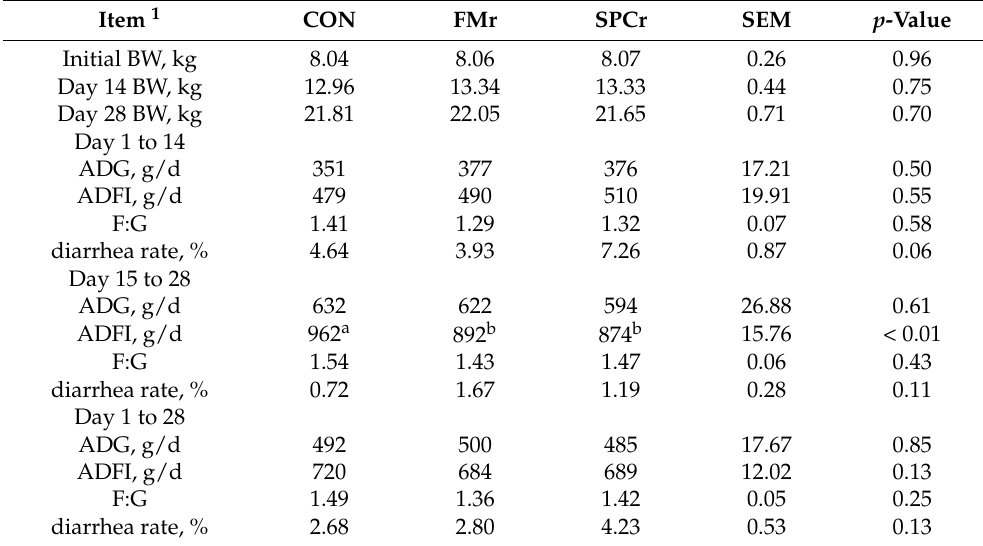
Table 3. Effects of replacing fish meal and soybean protein concentrate with degossypolized cotton- seed protein on growth performance and diarrhea rate in weaning